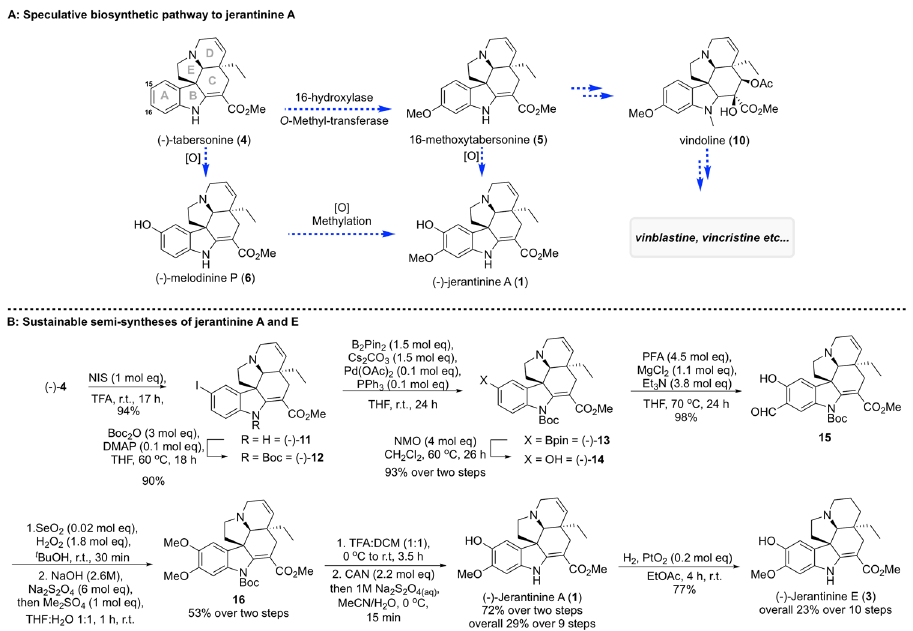
Figure 2. ( A ) Speculative biosynthetic pathway of jerantinine A and related vinca alkaloids ( 1 ) ( B ) Sustainable biomimetic semi-synthesis of ( − )-jerantinine A ( 1 ) and ( − )-jerantinine E ( 3 ), beginning from the proposed biogenetic precursor, ( − )-tabersonine ( 4 ).